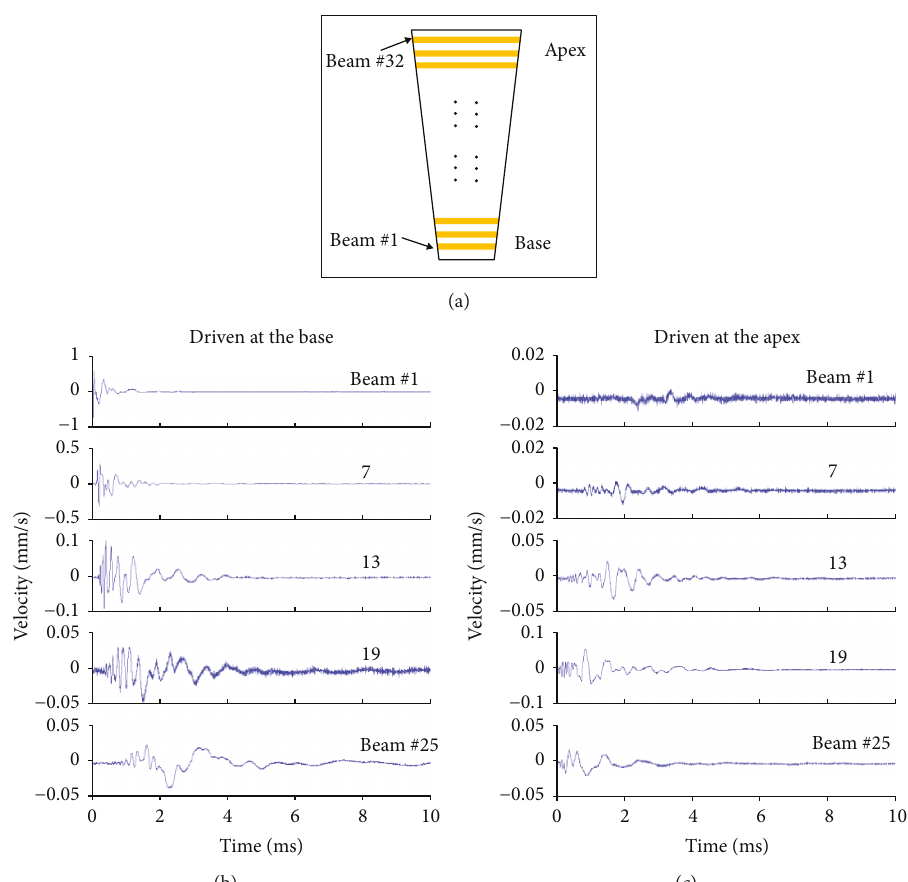
Figure 5: Vibration responses of a mechanical model of the cochlea. (a) Schematic view of the arti fi cial BM. The length of the copper beam varies from 4 mm at the base (narrower) to 8mm at the apex (wider). A total of 32 beams are placed on a membrane. The distance between beam #1 and #32 is about 20 mm. (b) BM vibration of the model while it was driven at the base, the narrowest, and thus the sti ff est end. The driver was placed on the membrane right next to beam #1 at the base. Note that the scale of y -axis decreases from the top to the bottom, showing that the vibration amplitude was attenuated during the propagation. (c) BM vibration while it was driven at the apex. The driver was placed on the membrane at beam #29, close to the